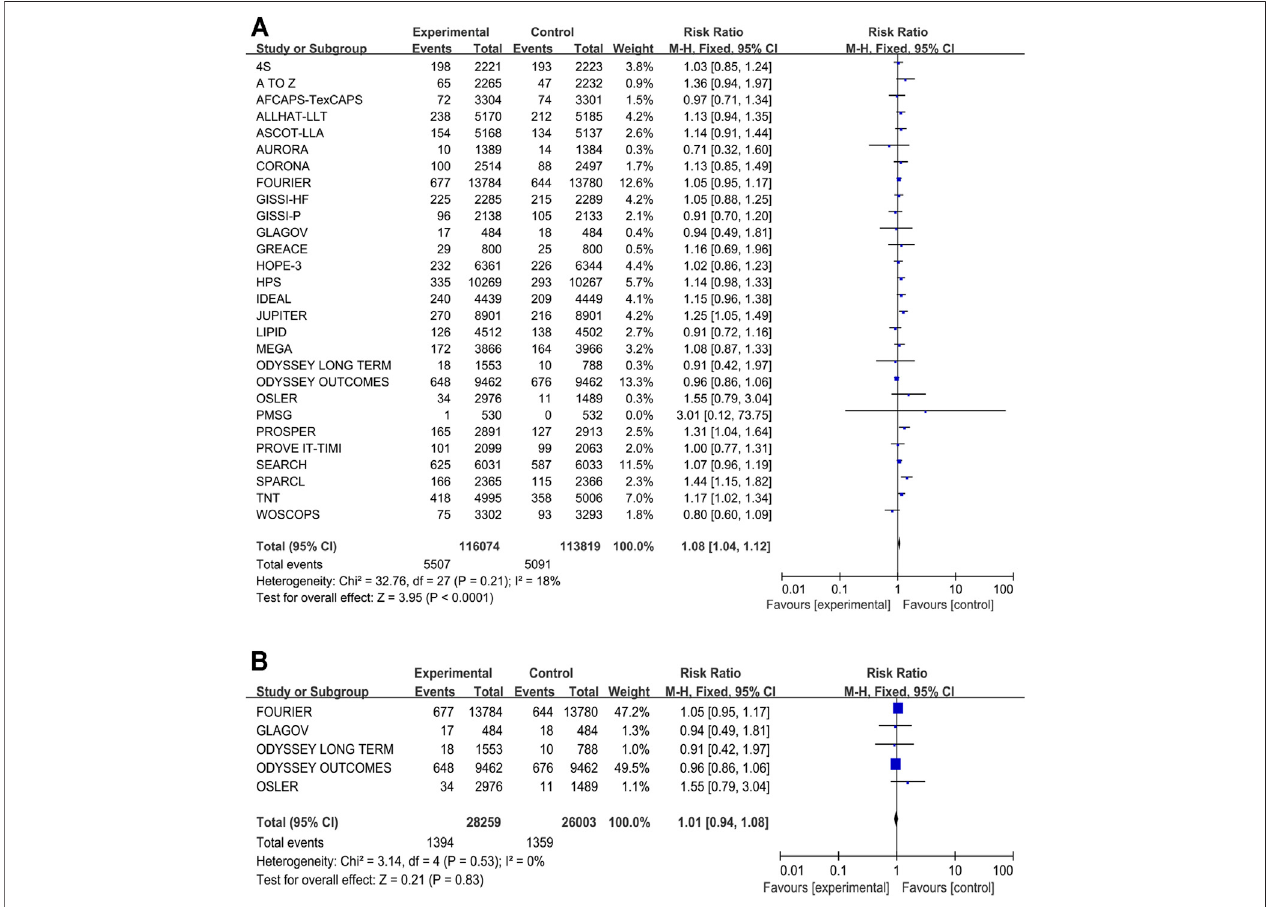
FIGURE 4 | Meta-analysis of new-onset diabetes. (A) Forest plots of new-onset diabetes between the more intensive treatment and the less intensive treatment. (B) Subgroup meta-analysis of new-onset diabetes between PCSK9 inhibitors and statins. CI, con fi dence interval.